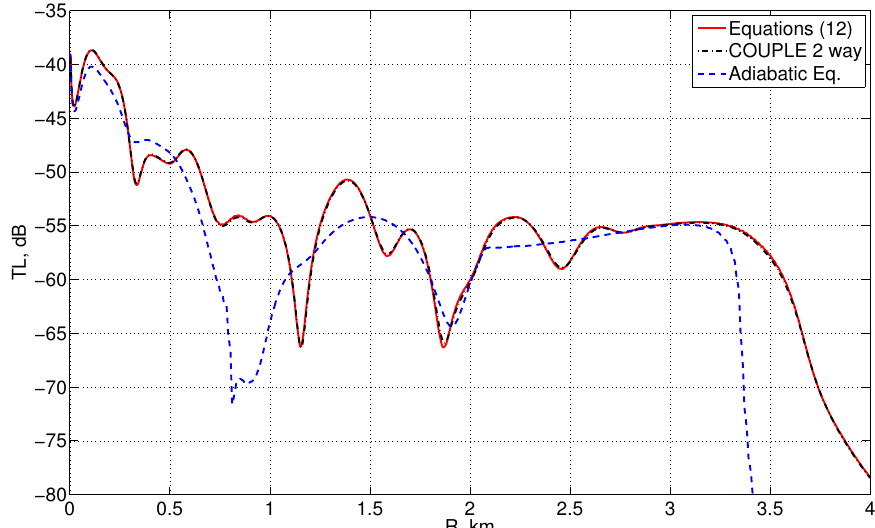
Figure 1. Transmission loss for the propagation along the bottom slope as a function of distance r from the source in ASA wedge benchmark computed by solving equations for mode amplitudes (23). The reference solution is obtained by the COUPLE program [24]. Adiabatic solution is shown for comparison. The source is deployed at the depth of 100 m, and the depth of the receiver is 30 m.